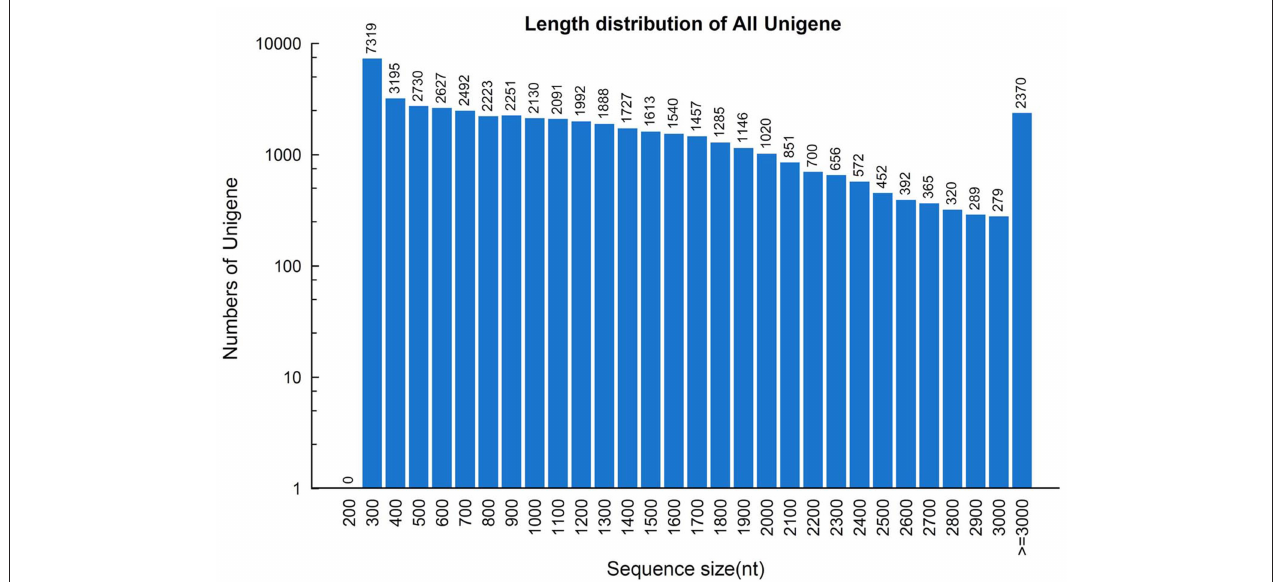
FIGURE 2 | Length distribution of the unigene assembly in the Sinapis alba transcriptome.